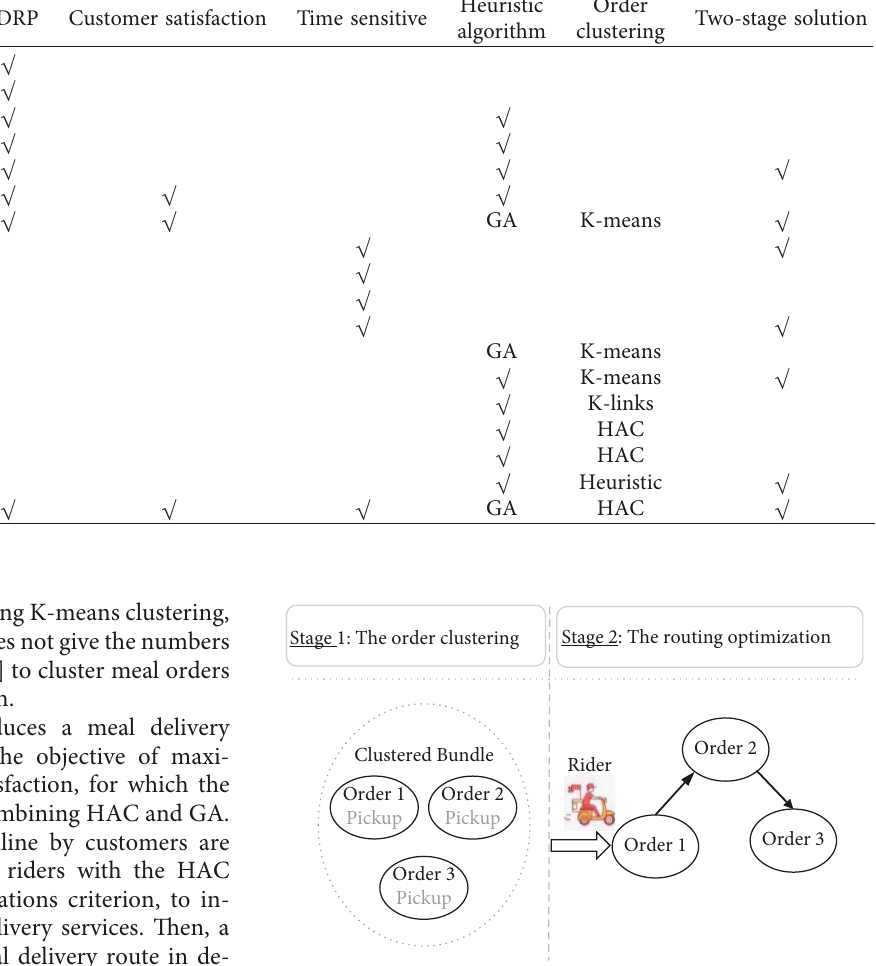
Figure 1: Meal order cluster first-route second